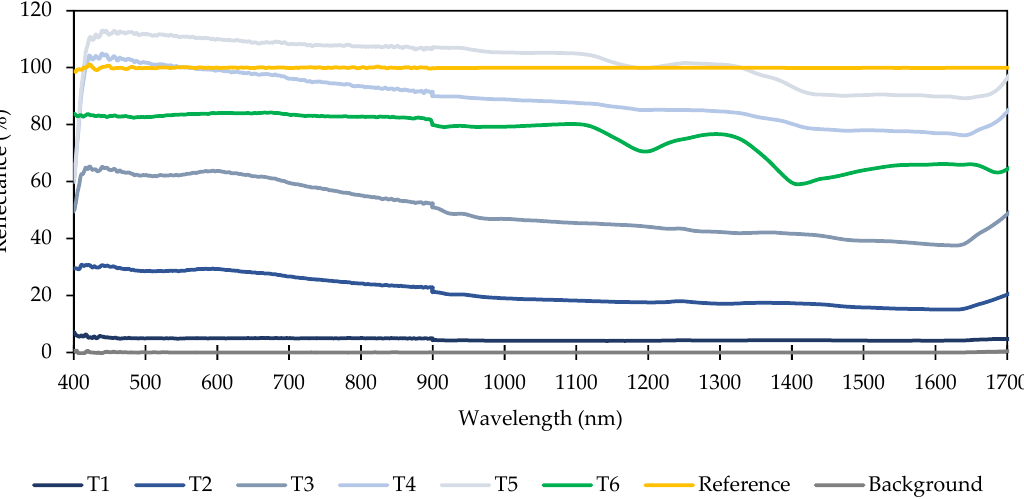
Figure 3. Spectra of reflectance targets (T1 through T6) with lab spectrometers calibrated using the Spectralon calibration standard. UV, VIS, and NIR spectrometers used in the target classification experiment under ambient light conditions only measured light up to 650, 800, and 1100 nm, respectively. Reference and background spectra show reflectance of the calibration standard after calibration with the light source on and off, respectively.